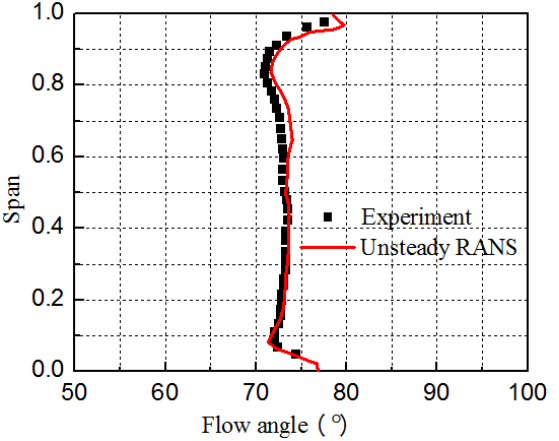
Figure 5. Flow angle at stator outlet.